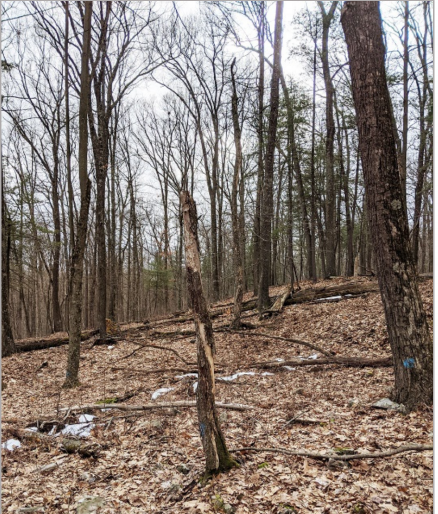
Figure 21. Example of short snag missed due to the height ranges used for voxel